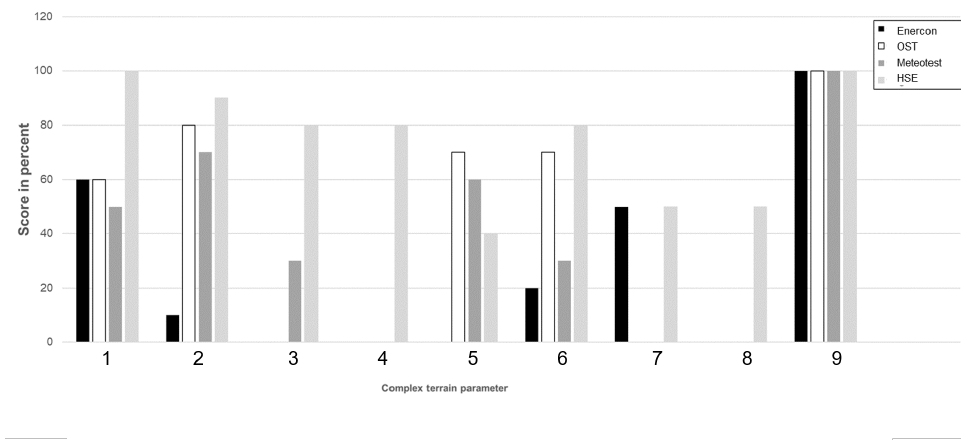
Figure A6. Answers to the ten complex terrain questions for Site 3.